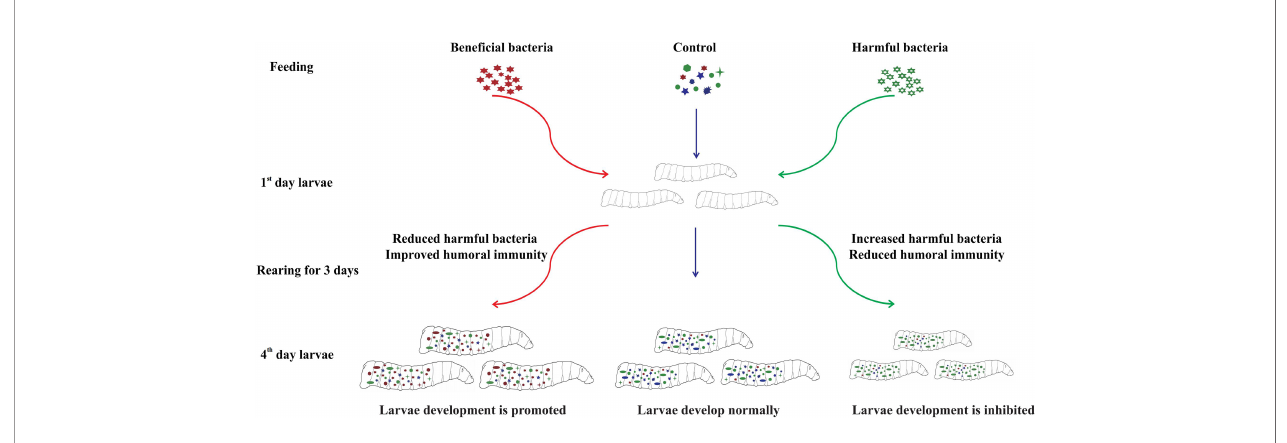
FIGURE 8 | Schematic diagram of the effects of novel isolated bacteria on house fl